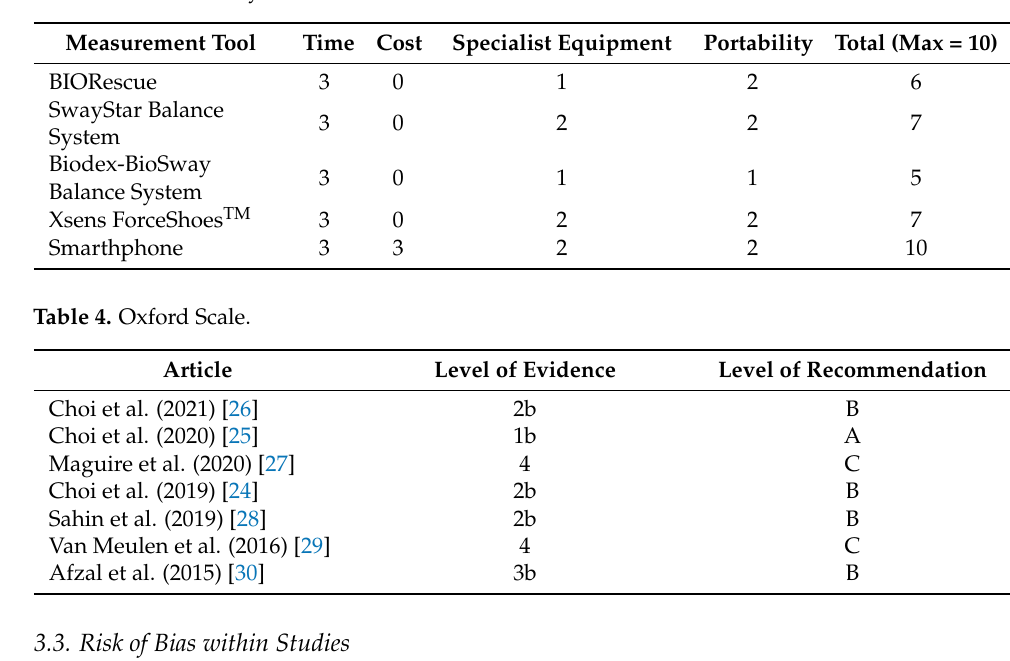
Table 3. Clinical utility of the selected measurement tools.